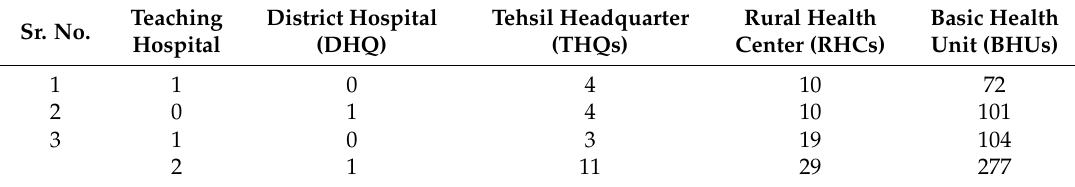
Table 2. Hospitals in the